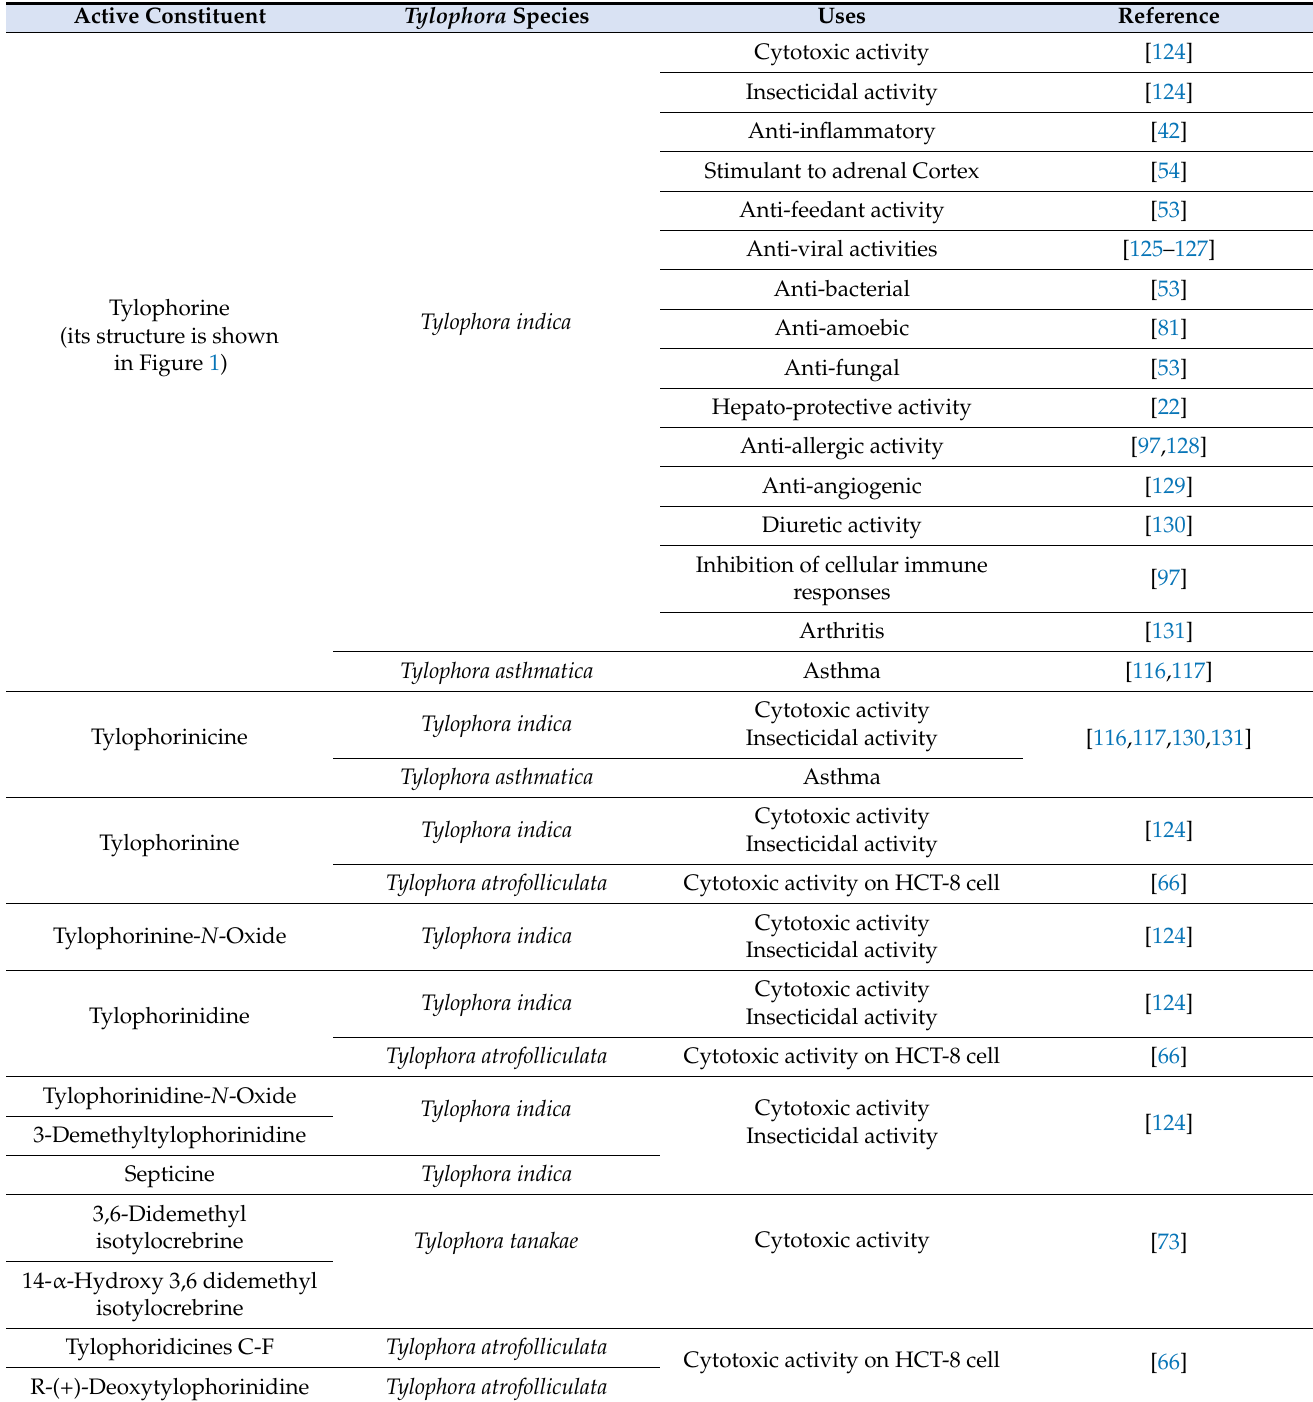
Table 6. Biological activities of alkaloidal constituents isolated from plants of the genus Tylophora